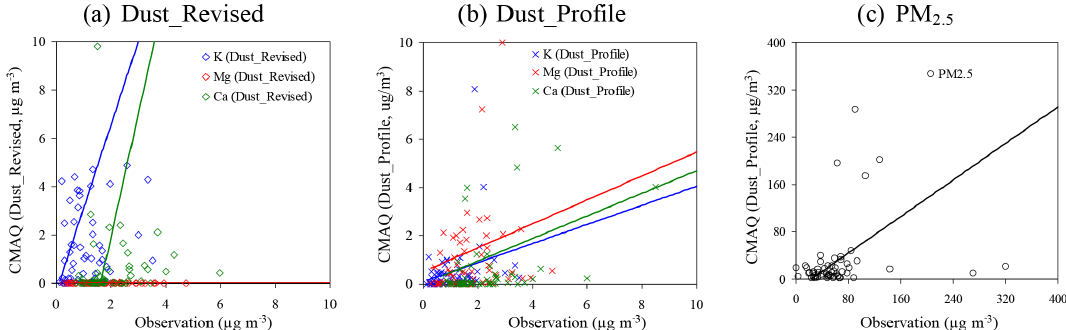
Figure 5. Model evaluations of CMAQ-simulated metal tracers against observations from Fudan University (shown in Table 5) at Duolun and Yulin for (a) Dust_Revised and (b) Dust_Profile scenarios. Evaluation statistics are shown in Table 6. Note that simulations and observations of K + and Mg + are upscaled by 5 and 10 times, respectively, to make them comparable with Ca + 2 CMAQ-simulated PM 2 . 5 at Duolun and Yulin.